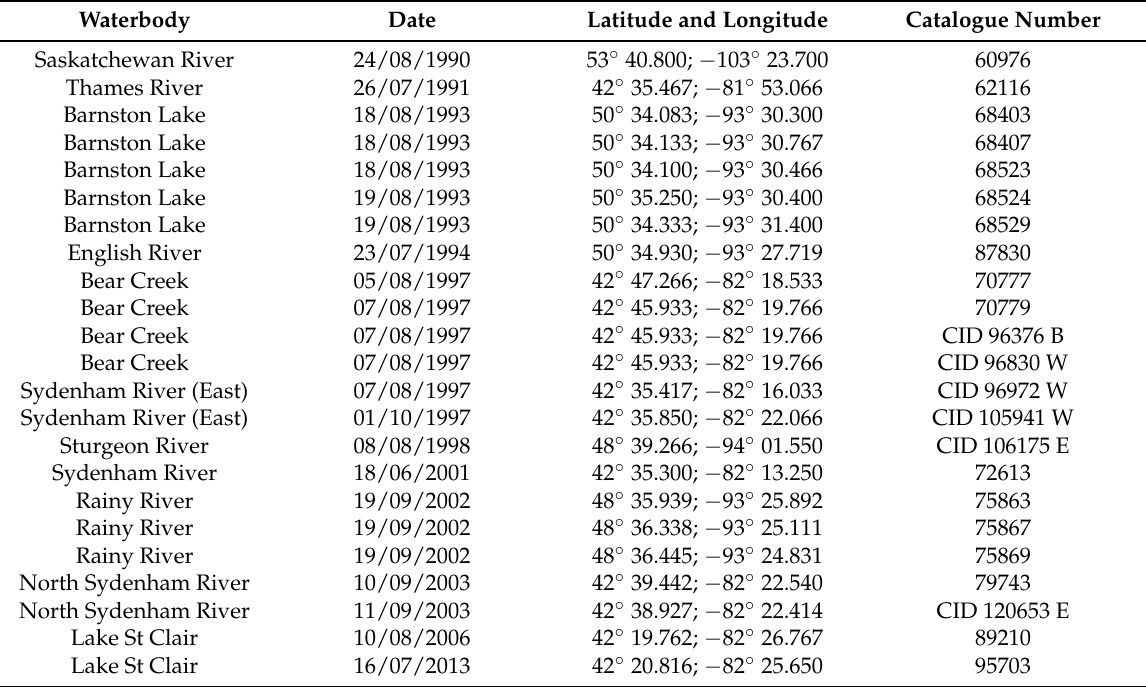
Table 3. ROM River Darter collection records from